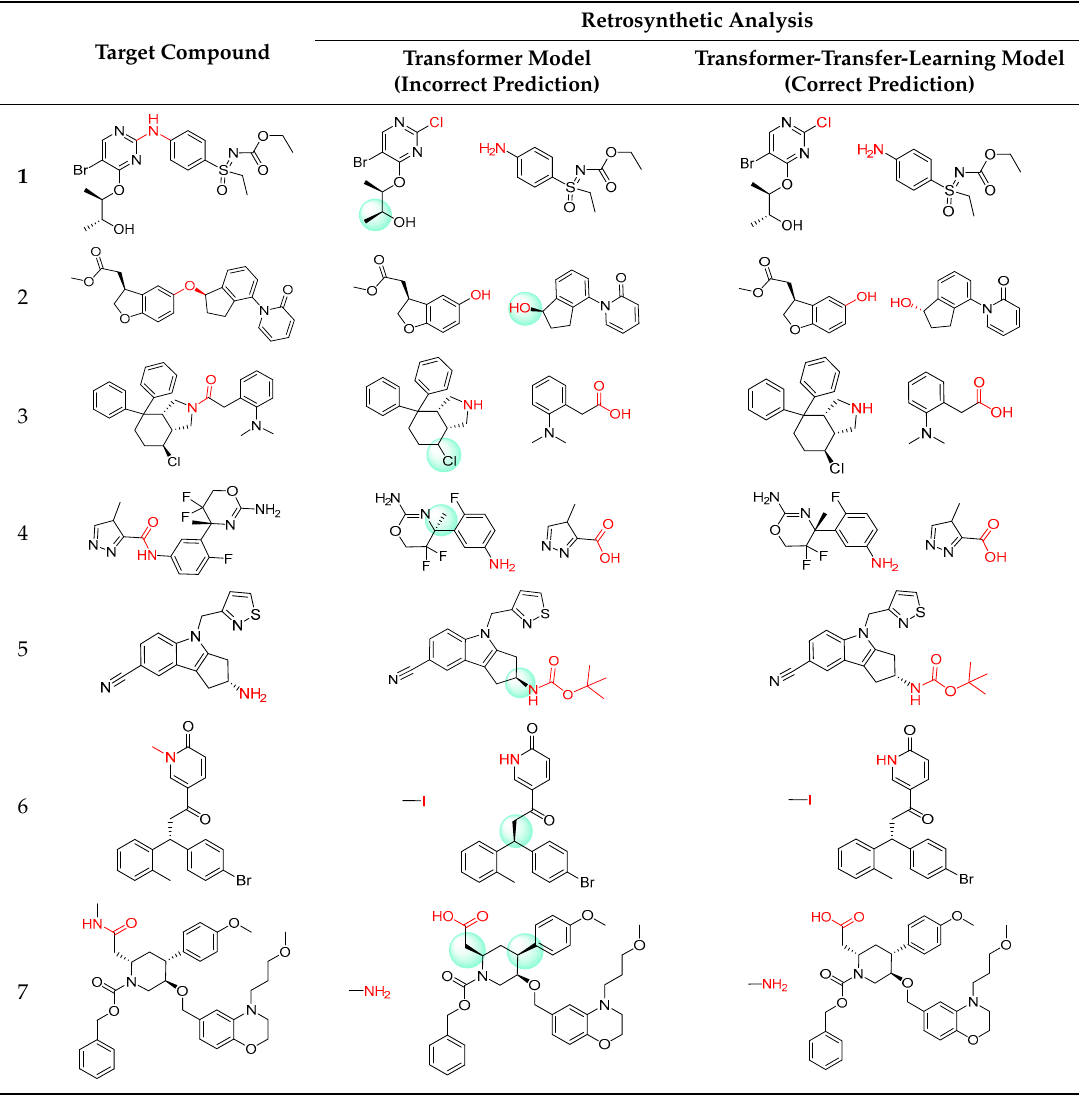
Table 7. Comparisons and representative examples of the Transformer and Transformer-transfer-learning models in retrosynthetic prediction with chiral carbon atoms.